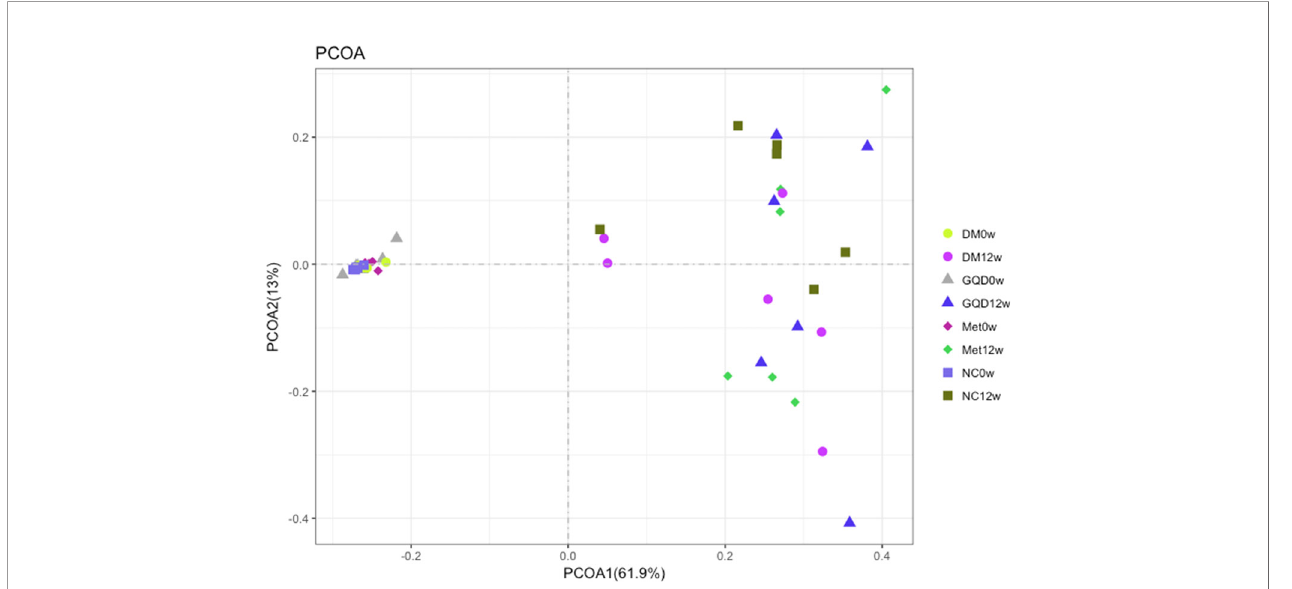
FIGURE 4 | Comparison of the gut microbiota structure among different groups. Bray-Curtis distance PCoA of the rat fecal microbiota before and after different treatments.